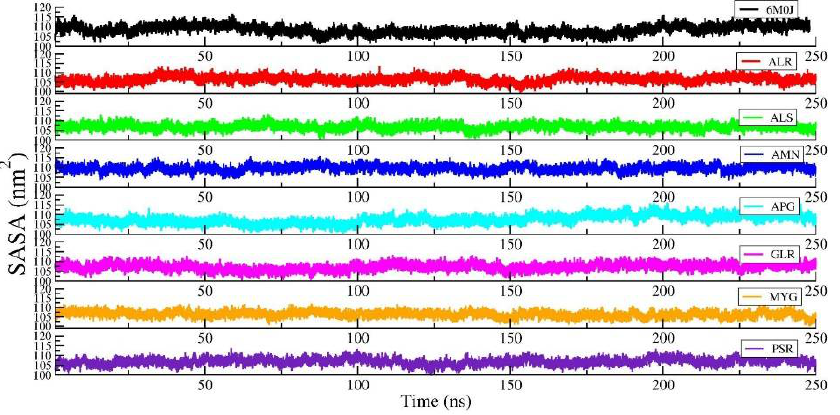
Figure 6. Radius of gyration (Rg) of backbone of the protein from the production run of all seven protein–ligand complexes and compared with protein in water simulation.